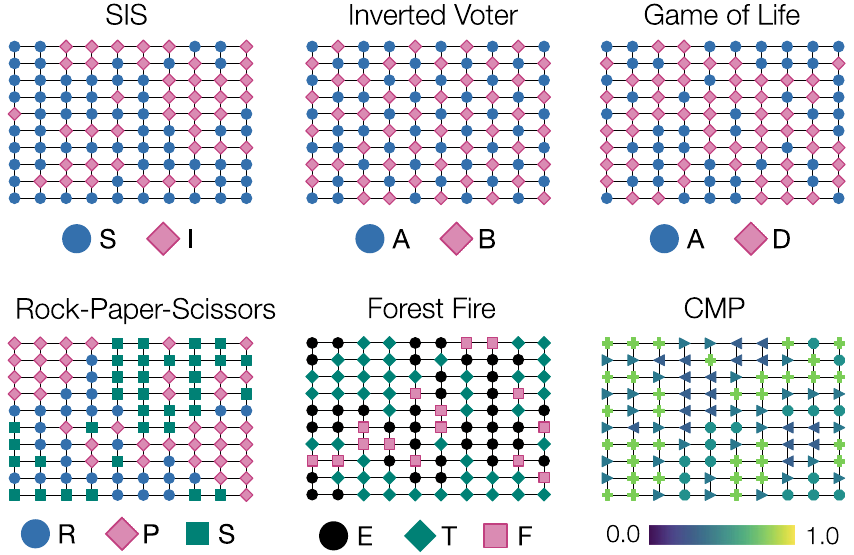
different types of cluster